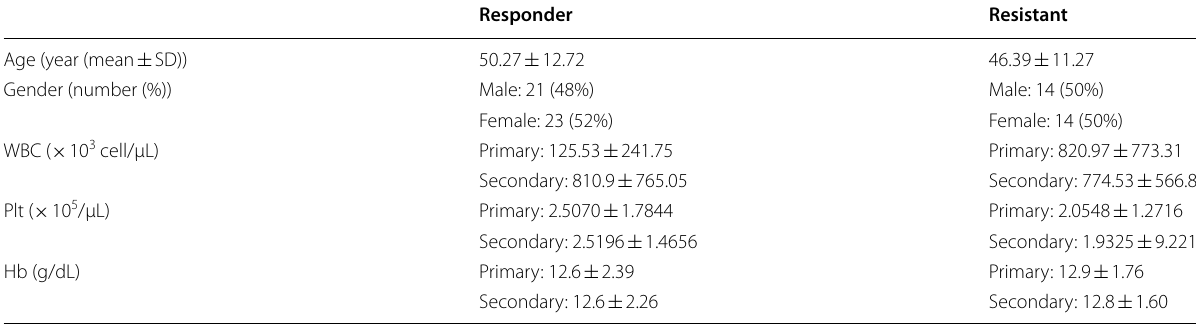
Table 1 Demographic and clinical characteristics of study